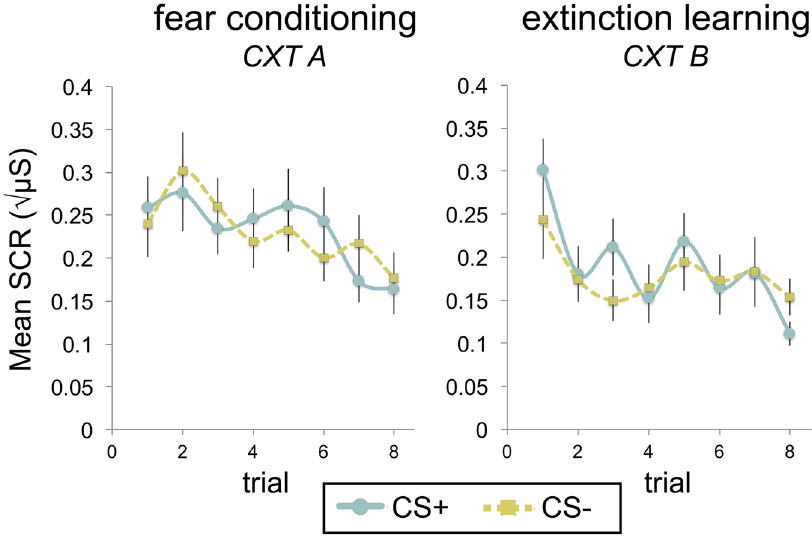
Figure 3. Skin conductance response (SCR) during fear conditioning and extinction learning in children. CS + and CS − refer to the avatar (virtual person) that is paired and unpaired with the US (white noise burst), respectively. SCRs to both the CS + and CS − declined during fear conditioning, consistent with previous fear conditioning studies in adults and in children 17–20 . Children show a significant decline in SCRs to the CS + and the CS − during extinction, suggesting intact extinction learning. Error bars represent standard error. Abbreviations: CS, conditioned stimulus; US, unconditioned stimulus; CXT, context.